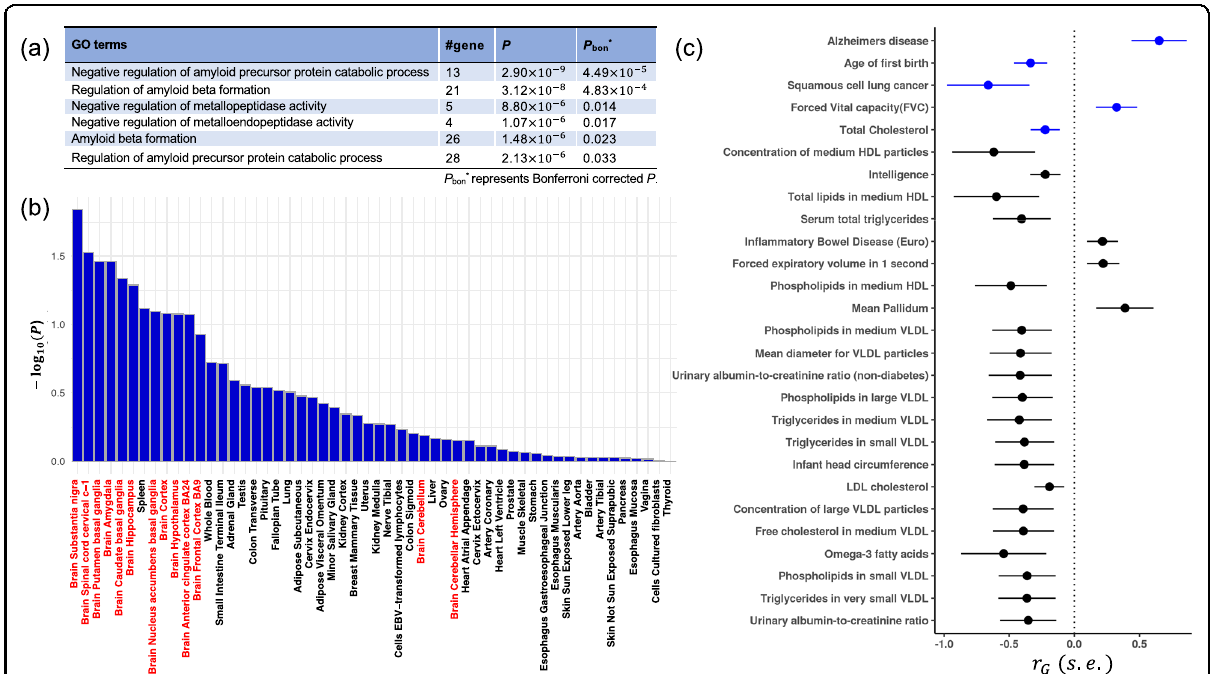
Fig. 4 Gene-set analysis and genetic correlations. a P bon* represents the Bonferroni-corrected P . b The red lettering indicates brain regions. c Diseases and traits with genetic correlations with AD ( P < 0.1) are shown. Those shown with blue symbols represent diseases and traits with P <